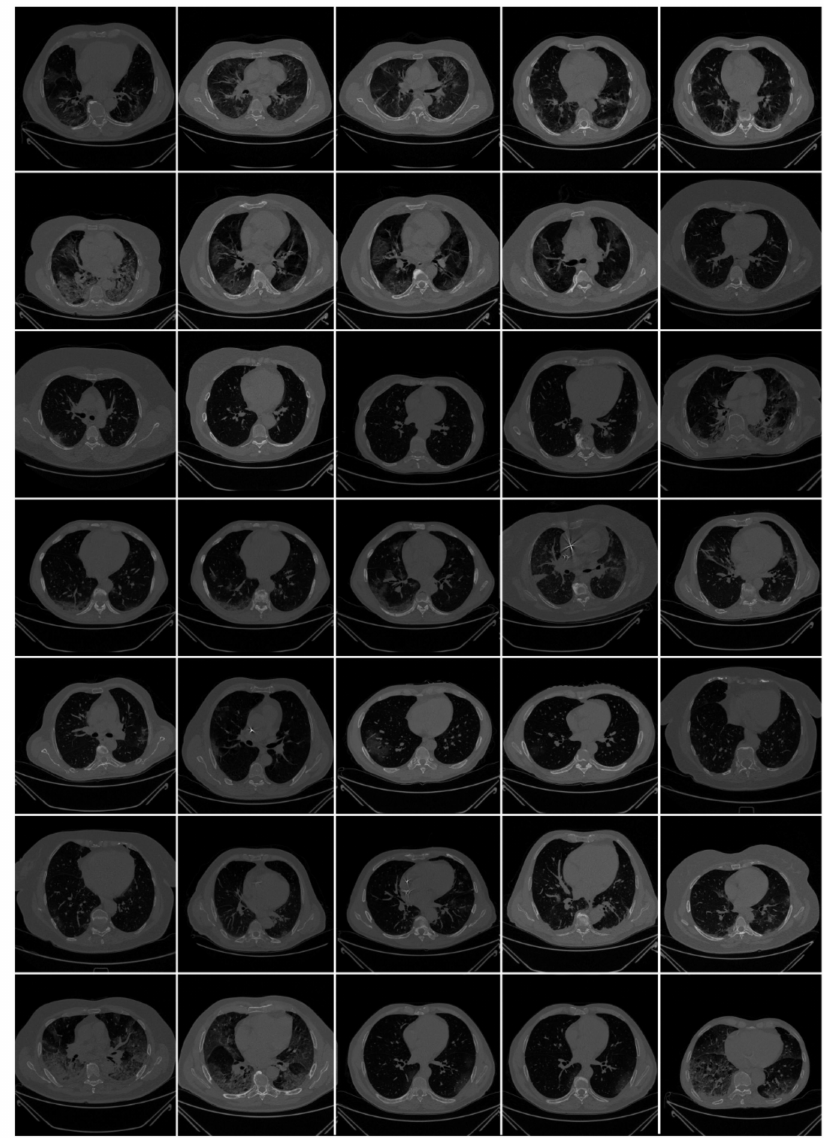
Figure 2. Raw CT images from NOVARA, ITALIAN dataset